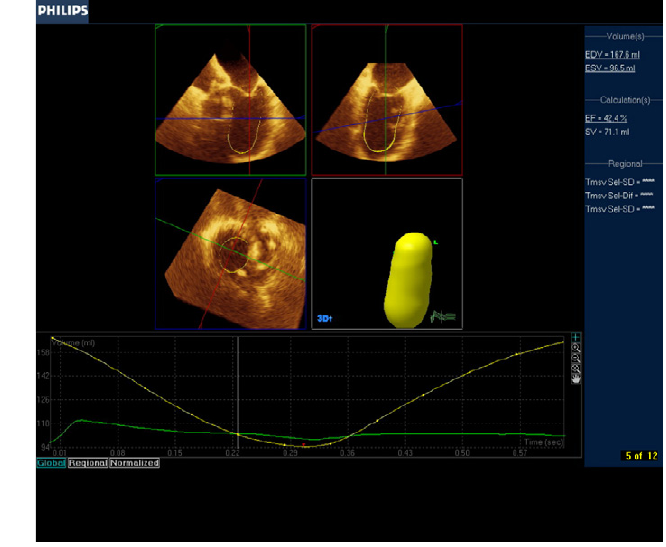
Figure. 7 A 3D full volume data set permits accurate depiction of segmental wall motion abnormality and spatial geometry of apical aneurysm. The left ventricular reduction over time is shown in the lower